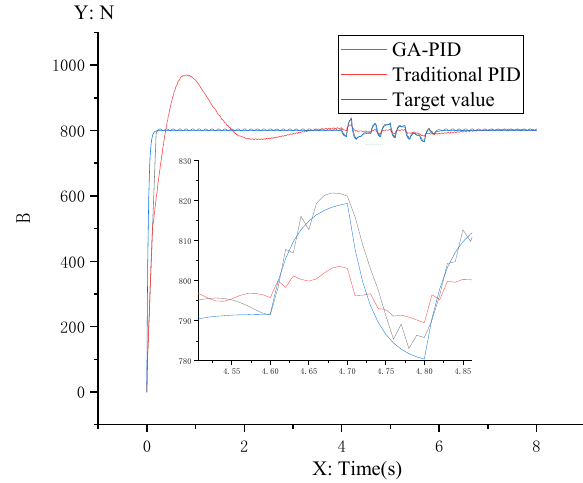
Figure 7. Propulsion control under the single coal hardness. Table 4. Simulation data of propulsive force under the single coal hardness.